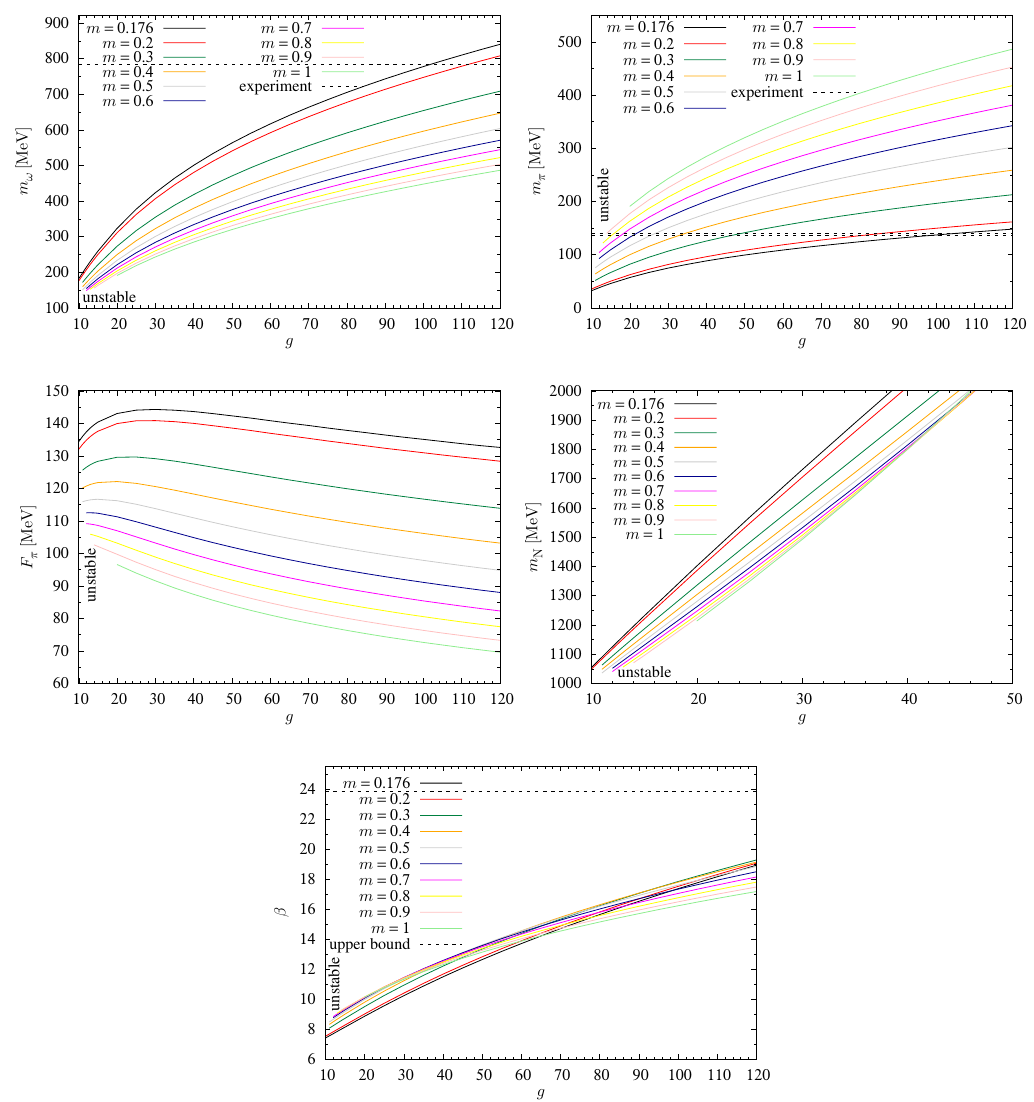
Figure 5 . Solutions that (cid:12)t to the nucleon radius and the helium-4 mass. The panels show the omega mass m ! , the pion mass m (cid:25) , the pion decay constant F (cid:25) , the nucleon mass m N and the coupling constant (cid:12) . The (cid:12)gure for m N has been cropped so as to better see the viable